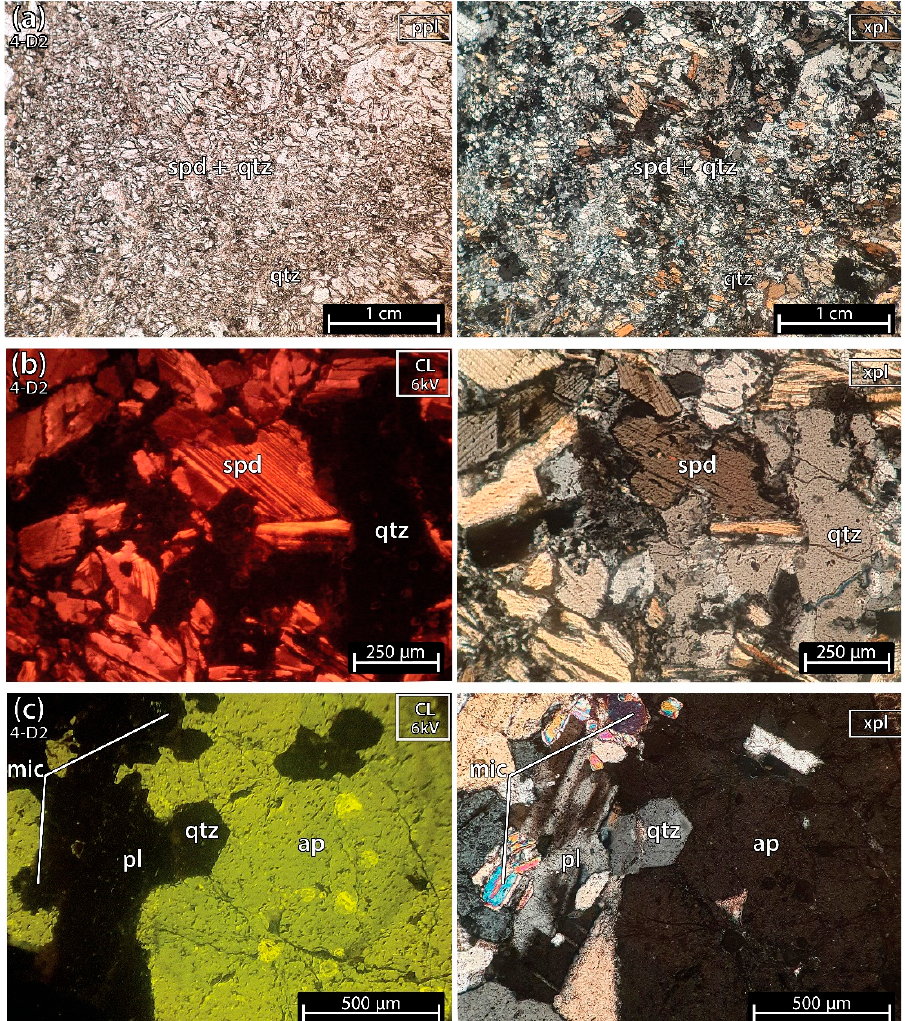
Figure 10. Microphotographs in parallel polarized light (ppl), crossed polarized light (xpl) and cold cathodoluminescence (CL) microscopy from a fragment of a mixture of spodumene (spd) and quartz (qtz) from sample 2 of the aplite-pegmatite 4 (4-D2), also known as 59-AL-22. ( a , b ) Mixtures of fine spodumene and quartz. ( c ) aplite-pegmatite rock constituted by abundant plagioclase (pl), quartz, white mica (mic), and several crystals of apatite (ap) with sizes between 100 µm and 2 cm.